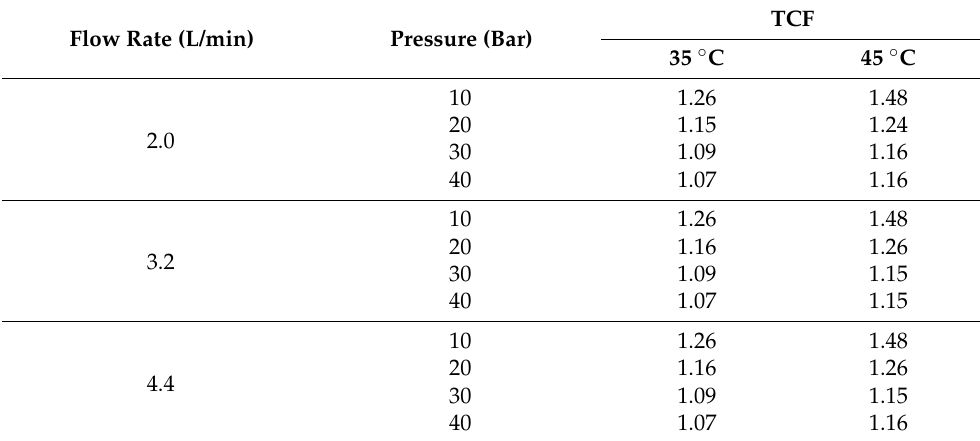
Table 2. Calculated TCF for permeate flux under different operating pressure and flow rates (C F = 100 ppm).